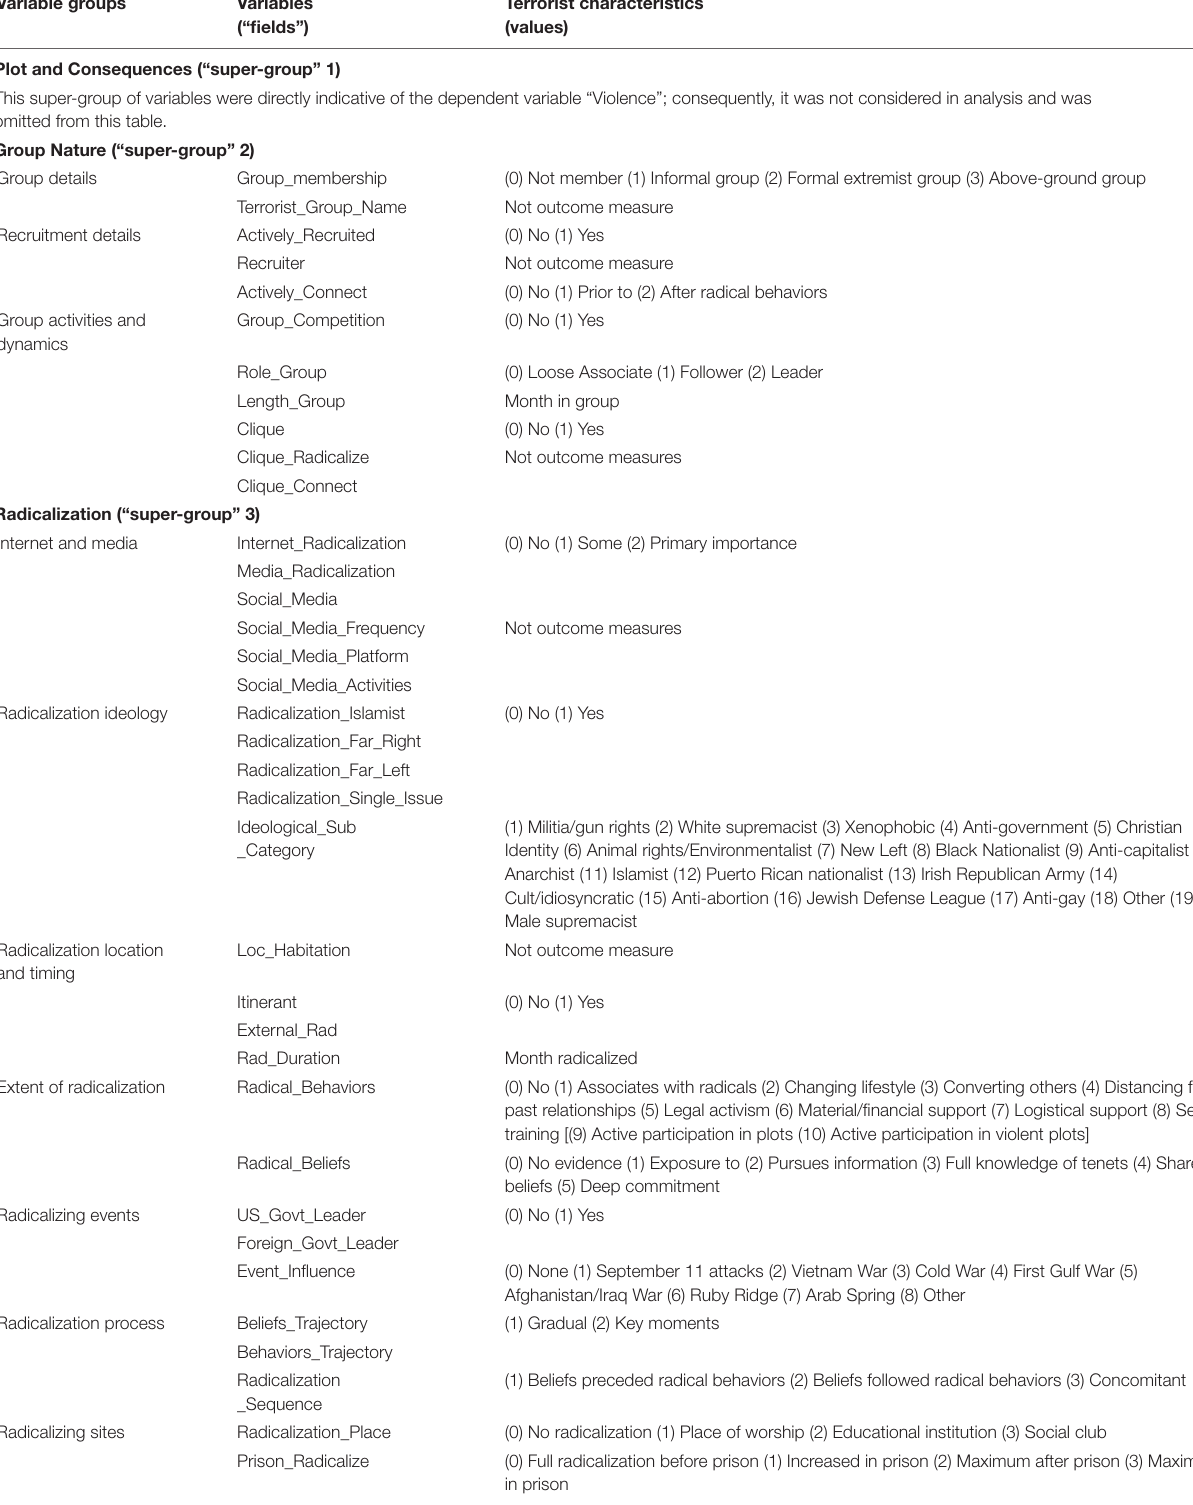
TABLE 1 | The structure of, and terrorist characteristics in, the PIRUS 2018 Database. Variable groups Variables Terrorist characteristics (“fields”) (values) Plot and Consequences (“super-group”